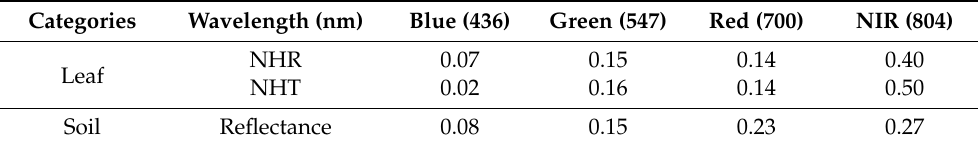
Table 2. Optical properties of maize leaf and soil